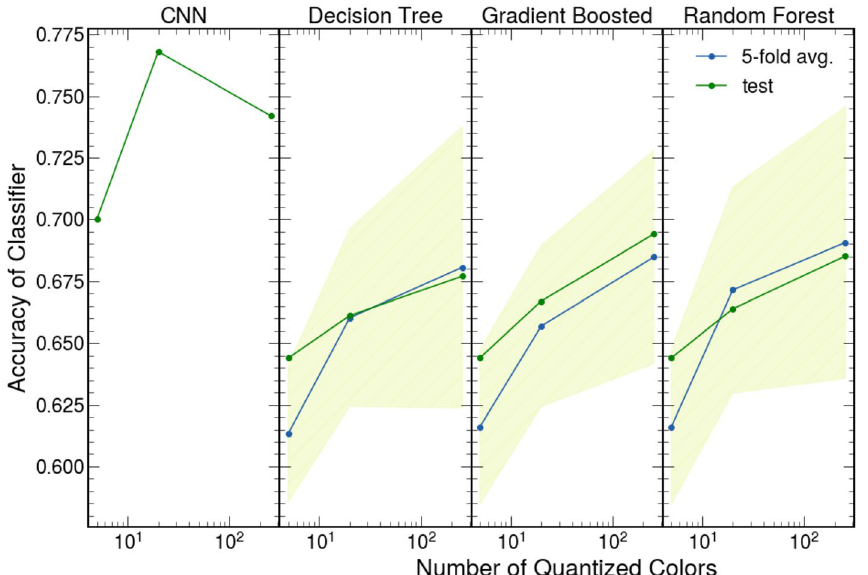
Figure 2. CNN and tree-based machine learning algorithms’ accuracies. The accuracy of CNN and tree-based algorithms depends on the number of color clusters in the recreated image. The tree-based methods and CNNs were trained and tested on images recreated with 5, 20, and 256 colors and 5, 20, and infinite (original image) colors. The CNNs’ accuracies (first panel) determined with a 75/25 train test split. Tree-based algorithms’ accuracies (last three panels) shown as the average test accuracy from the five-fold cross-validation used to select the algorithm’s hyperparameters (blue) and test accuracy from 75/25 train test split after this optimization (green). The standard error for the five-fold cross-validation test accuracy is represented by the shaded